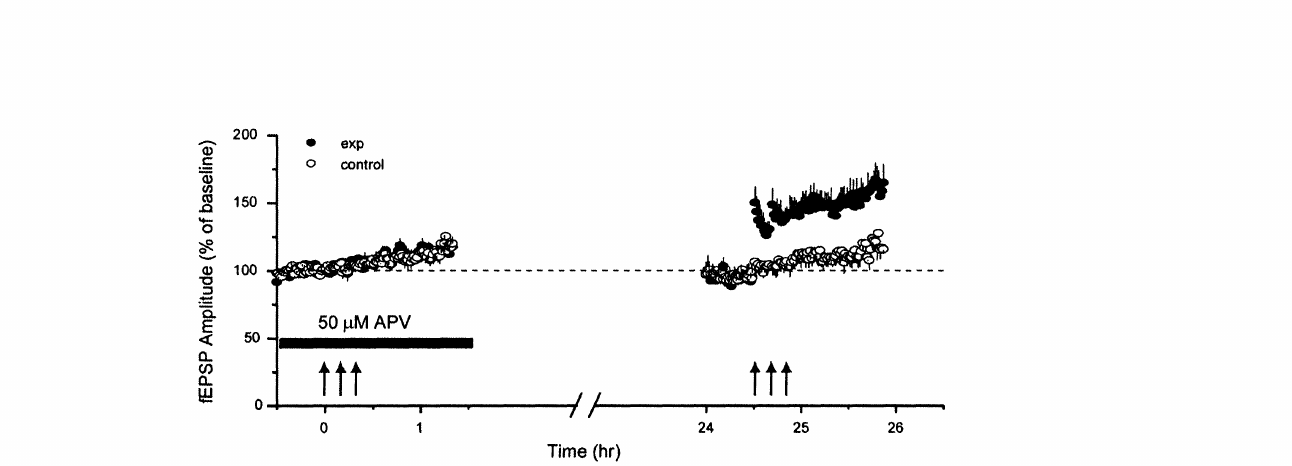
Fig. 2: Reversible blockade of LTP by APV in cultured hippocampal slices. High frequency stimulation was applied to one pathway (exp) while another unstimulated pathway received low frequency stimulation (control) in the presence of APV (50 ktM). Slices were returned to the incubator in culture medium without APV, and were tested the following day. Another high frequency stimulation was applied to the same pathway and responses measured for another 2 h. Each point represents the mean + S.E.M. (n 6) of the relative amplitude of fEPSPs in both pathways. Arrows indicate time of high frequency